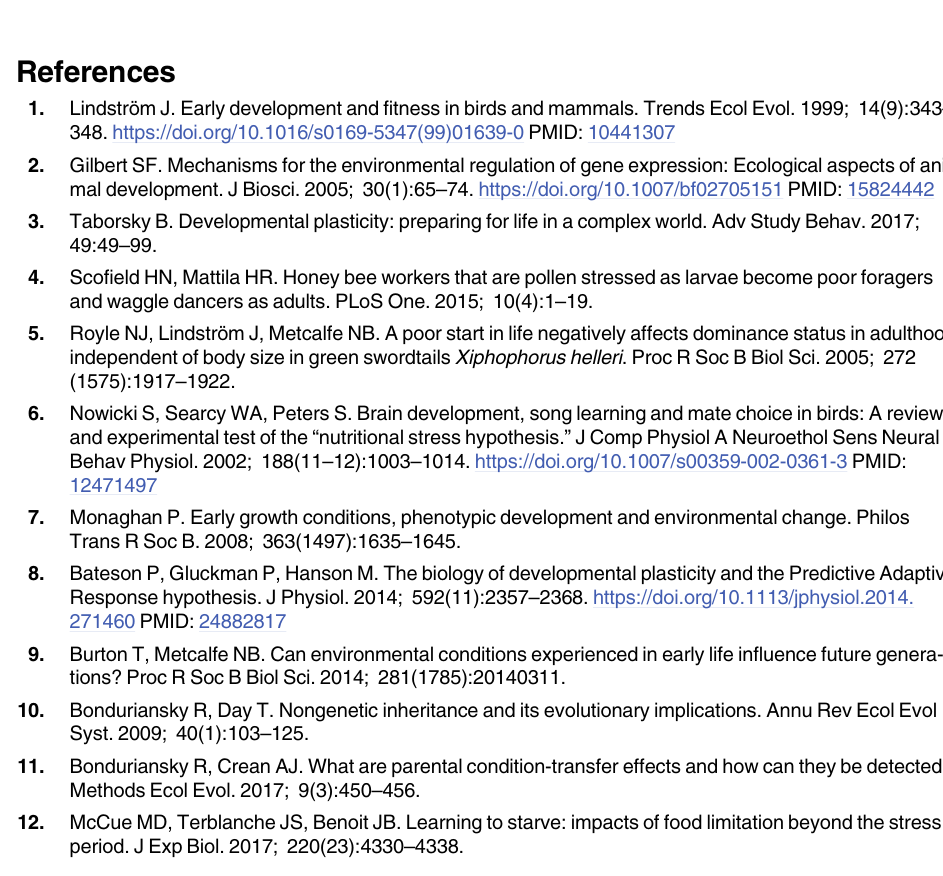
S1 Table. Complete raw data set of the